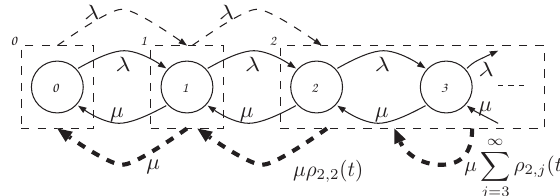
Figure 1: M/M/1 queue and a possible IMAP approximation of its output. The M/M/1 queue is depicted by solid lines